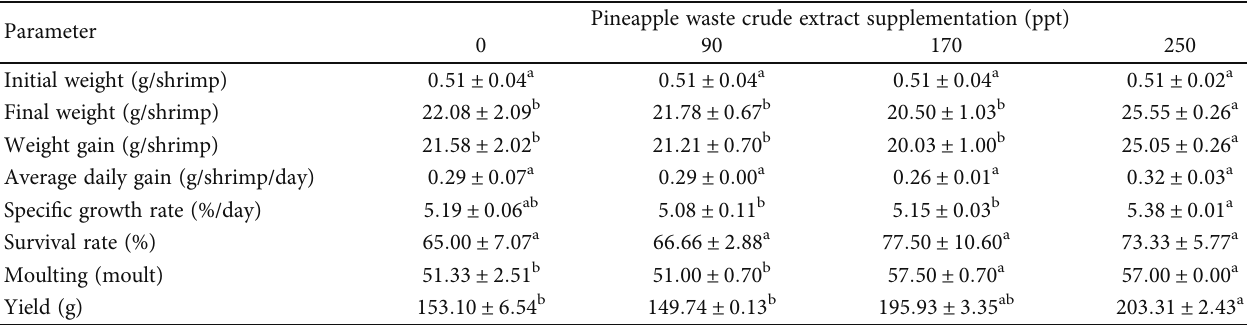
Table 1: Growth rate, survival rate, moulting, and yield of Paci fi c white shrimp fed with pineapple waste crude extract supplementation diet at di ff erent levels for 80 days.